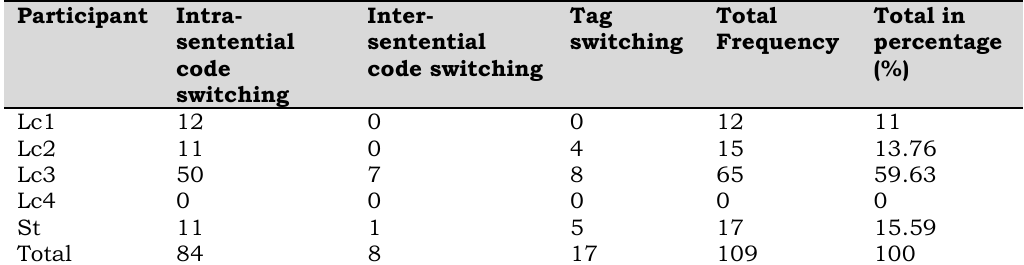
Table 2: Percentage of code switching used by each